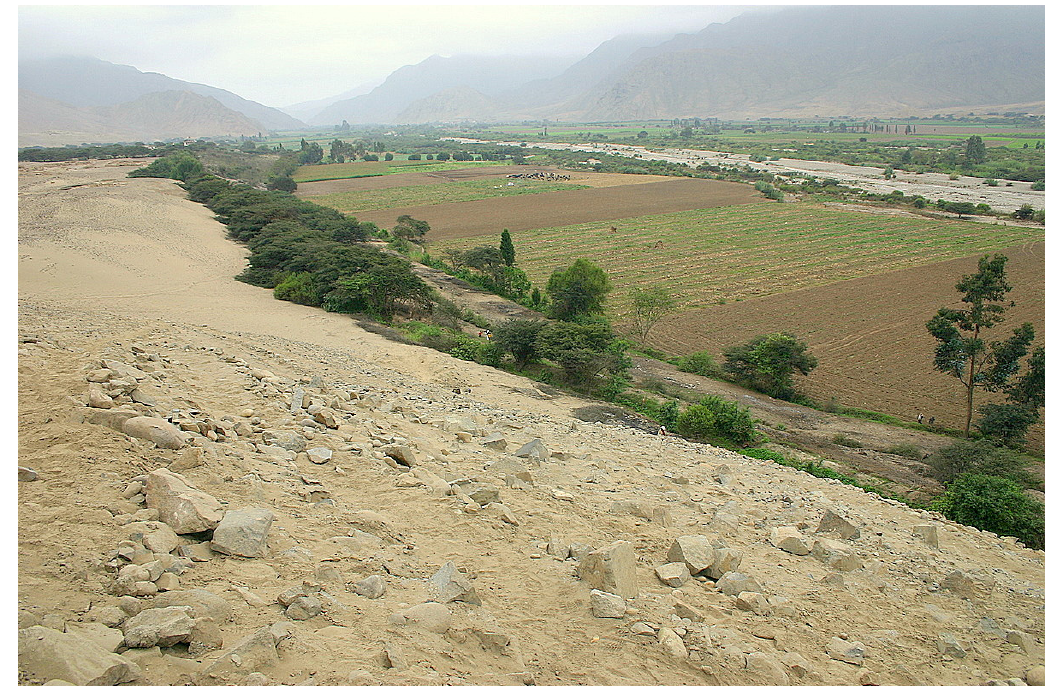
Figure 12. Supe Valley bottomlands below the southern elevated plateau that situates Caral and other sites shown in Figure 3. The Supe River separates current northern and southern agricultural fields.